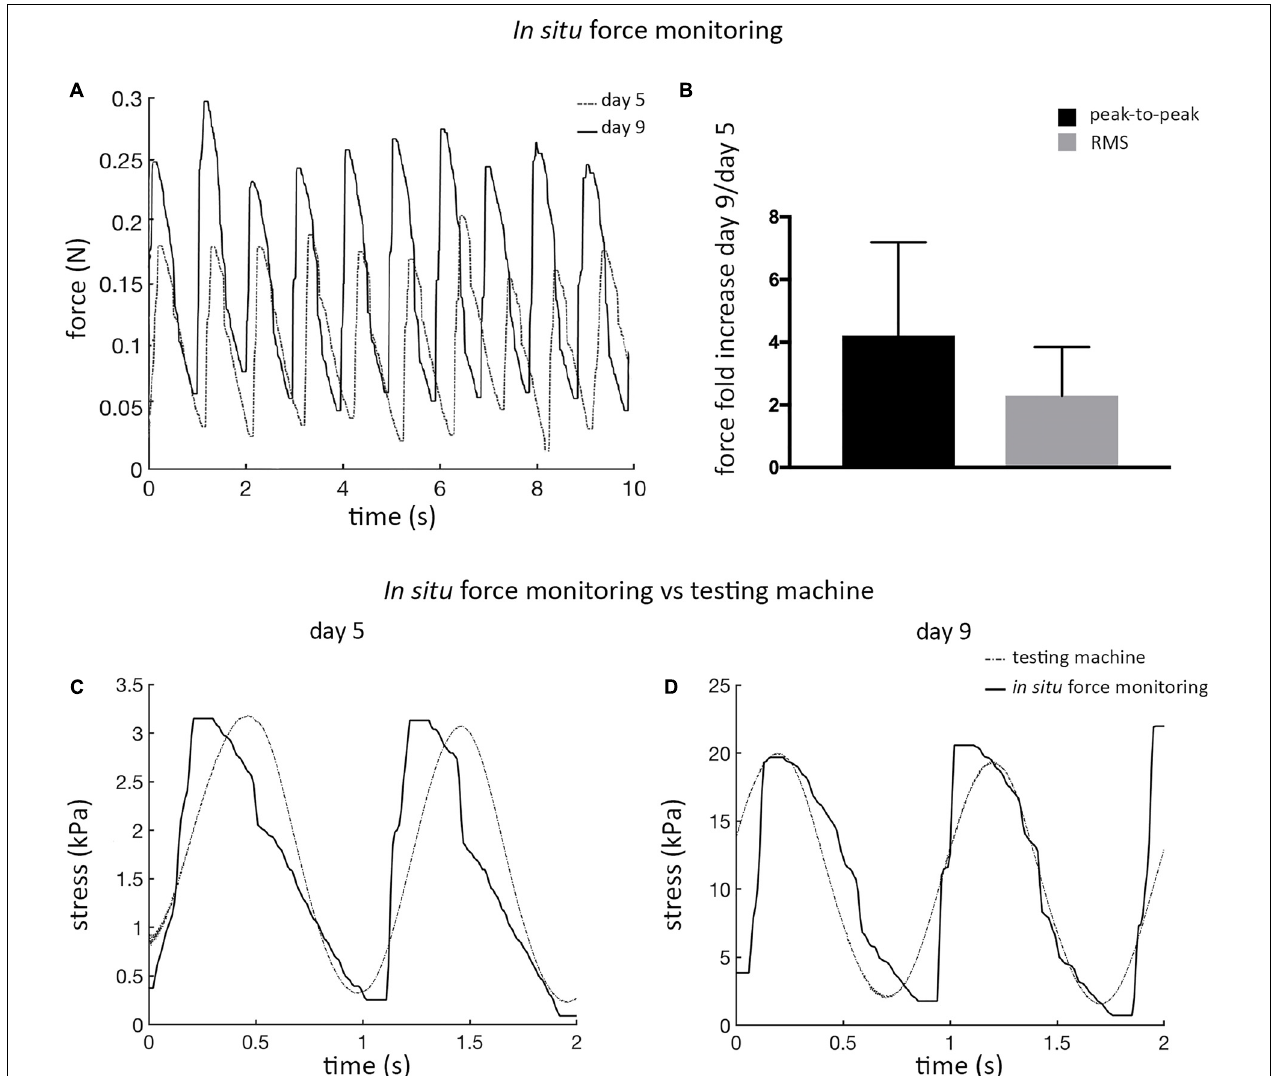
FIGURE 5 | ECT in situ bioreactor force monitoring. (A) Real-time force curves measured in situ by the bioreactor load cell at day 5 and at day 9 for an explanatory ECT undergoing cyclic stretch. (B) Graph showing the increase in the peak-to-peak force amplitude and in the root mean square (RMS) force magnitude at day 9 in comparison to day 5, respectively ( n = 3). Comparison of the stress vs. time curves obtained at days 5 (C) and 9 (D) from the bioreactor load cell (solid line) and from the standard testing machine (dotted line)